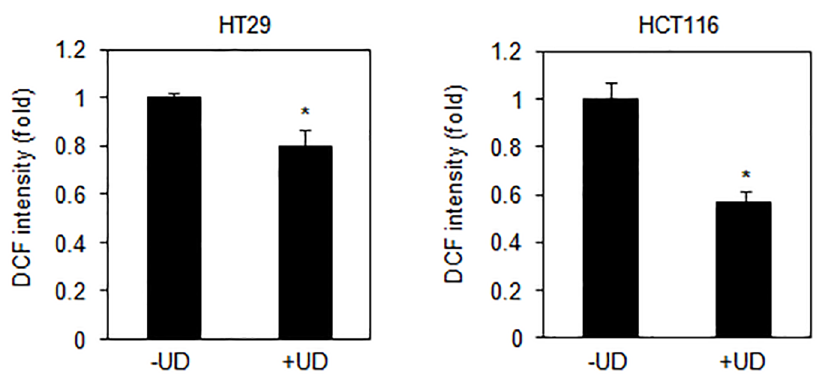
Fig 3. Effect of UDCA on removalof intracellular reactive oxygen species (ROS). HT29 and HCT116 cells were treated in 0.2 mM UDCA and stainedwith 25 μ M H2DCF-DA for 30 min. Total levels of intracellular ROS were detected by fluorescence activated cell sorting (FACS) analysis. Asterisks indicatestatistical significance(t < 0.04).